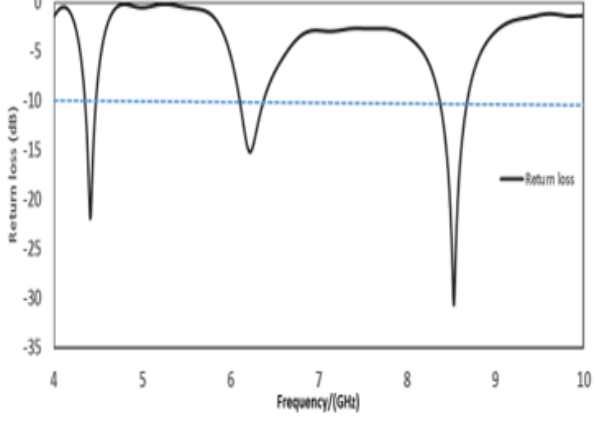
Fig. 1. .S 11 (dB) of the proposed